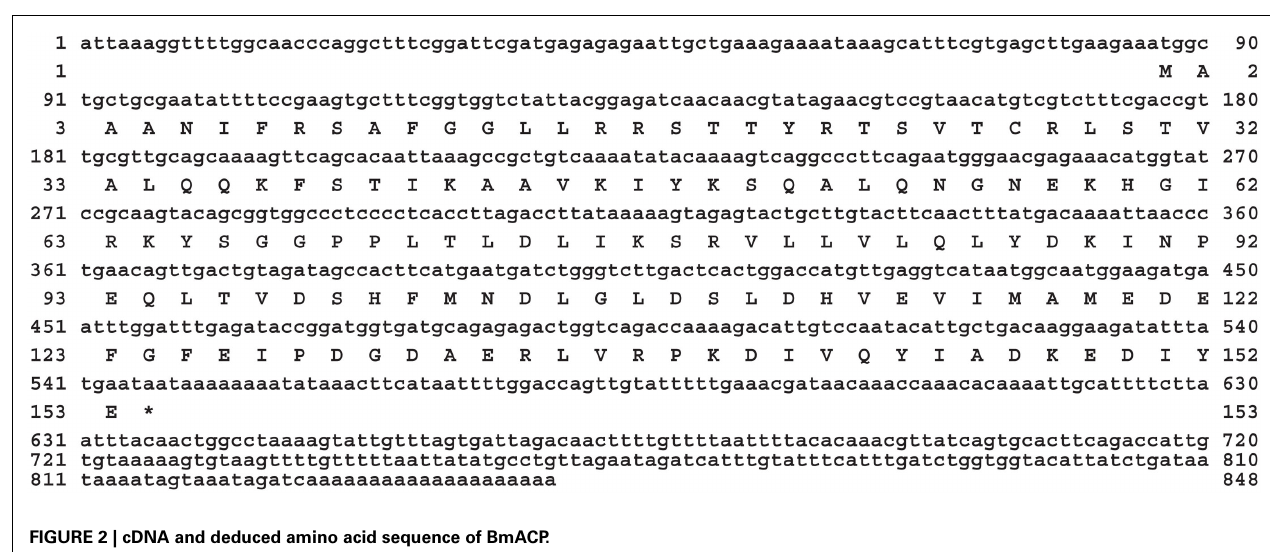
FIGURE 1 | Effect of RNAi treatment on in vivo bombykol production. One-day-old pupae were injected with 10 μ g dsRNA corresponding to the target genes or EGFP . Results are expressed relative to the mean value for